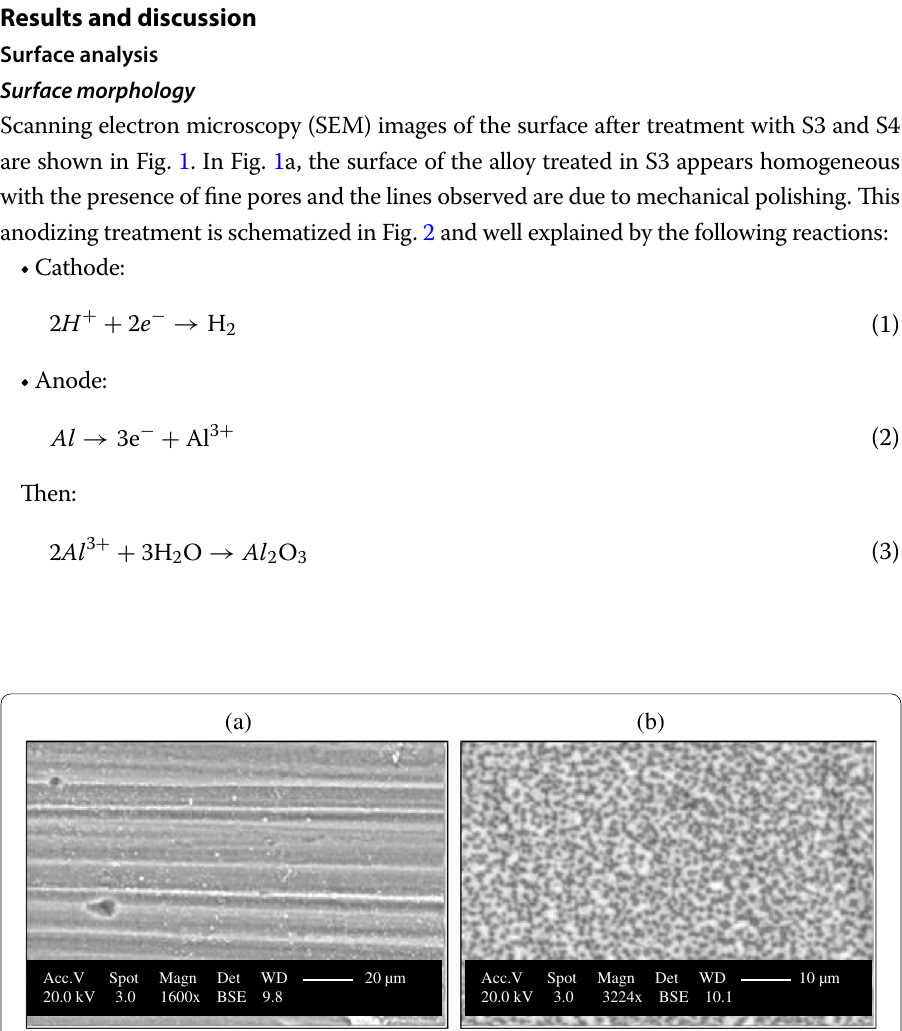
Fig. 1 SEM images the surface of the alloy after treatment with a S3 and b